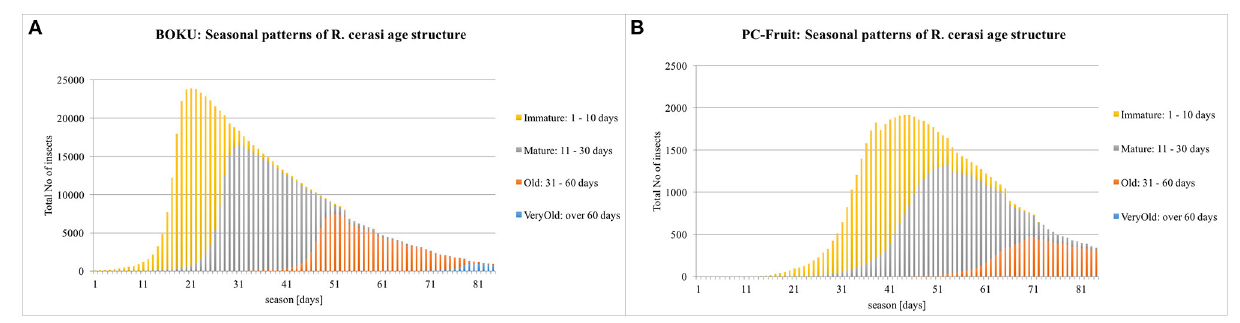
FIGURE 5 | Simulated seasonal changes in R. cerasi age structure. Assumption: NO pesticide treatment on the whole farm.